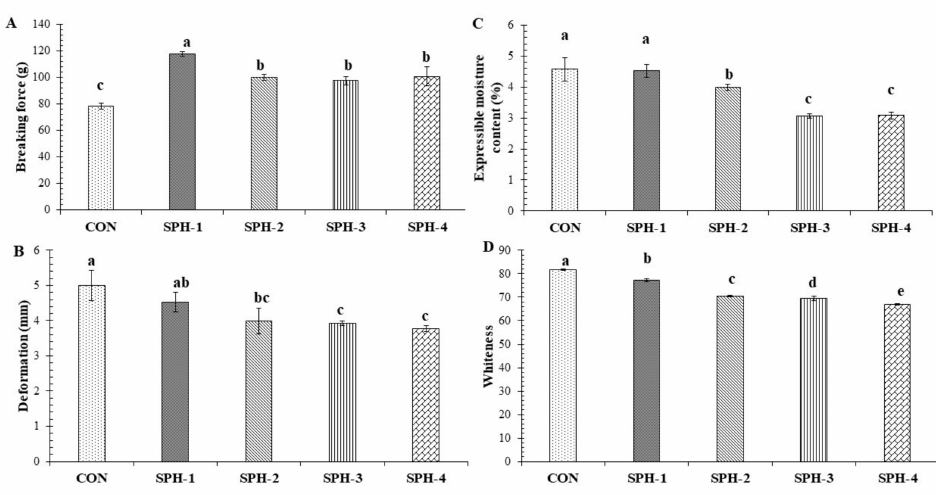
Figure 1. Breaking force ( A ), deformation ( B ), expressible moisture content ( C ), and whiteness ( D ) of gels from threadfin bream surimi without and with psyllium husk at different levels. Bars represent the standard deviation (n = 3). Lowercase letters on the bar indicate significant differences ( p < 0.05). CON: surimi gel (S) added without psyllium husk powder (PHP), SPH-1, SPH-2, SPH-3, and SPH-4: surimi gel added with 1, 2, 3 and 4% ( w/w ) PHP,